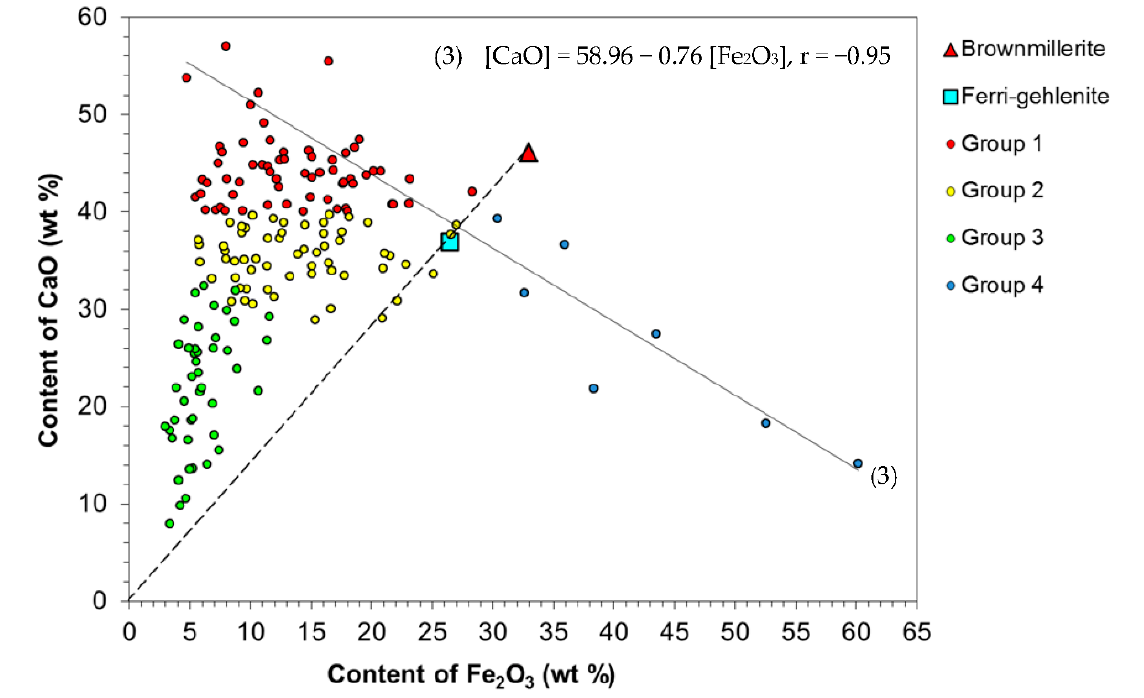
Figure 7. The CaO content as a function of the Fe 2 O 3 content for individual microspheres PM 1-2 . Compositions of the compounds correspond to their stoichiometric formula from Refs. [39,57].